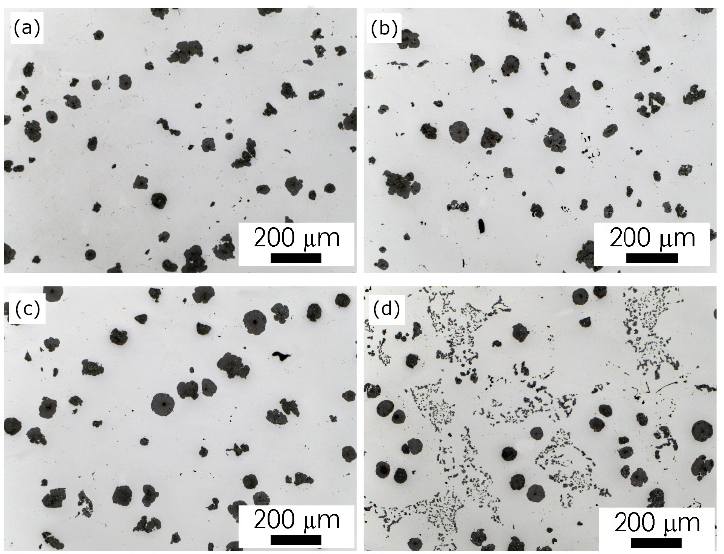
Figure 8. Graphite nodules morphology in the examined castings, LM, non-etched cross sections, microscope magnification 100 × ; ( a ) Casting No. 1 (acidic molding sand No. 1), ( b ) Casting No. 2 (acidic molding sand No. 2), ( c ) Casting No. 3 (alkyd molding sand No. 3), ( d ) Casting No. 4 (alkaline molding sand No. 4).